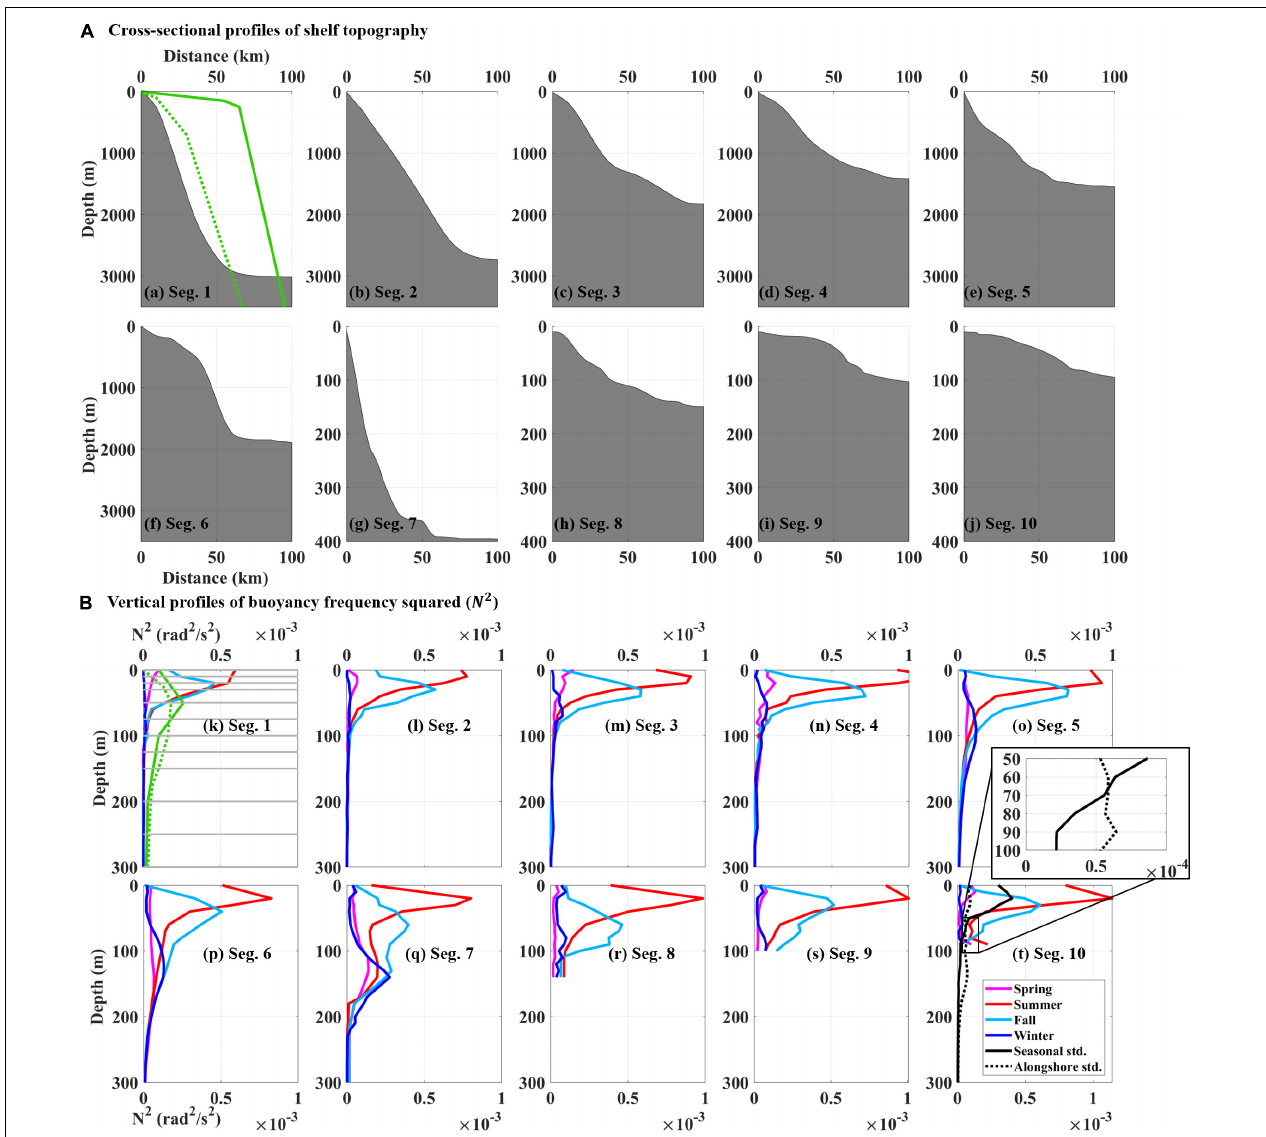
FIGURE 2 | (A) Cross-sectional profiles of the shelf topography within the coastal area around the KP [Segs. 1–10; from (a–j) ] and (B) vertical profiles of the squared buoyancy frequency ( N 2 ) averaged over four seasons (spring, summer, fall, and winter; pink, red, sky blue, and blue colors, respectively) for 10 segments [Segs. 1–10; from (k–t) ] at the upper 300 m. In (a–j) , water depth ( y -axis) ranges from the surface to 3,500 m for Segs. 1–6 and 400 m for Segs. 7–10, respectively. In (a,k) , the cross-sectional profiles of shelf topography and vertical profiles of N 2 for the East Australian coast (Church et al., 1986) and west coast of Peru (Brink, 1982; Illig et al., 2018) are overlaid with green solid and dotted lines, respectively. In (k) , the 15 standard depths of the NIFS hydrographic observations are denoted by gray horizontal lines. In (t) , standard deviations from the seasonal-mean and alongshore-mean N 2 (seasonal std. and alongshore std.) are shown with black solid and dashed lines, respectively, and zoomed in at depths 50–100